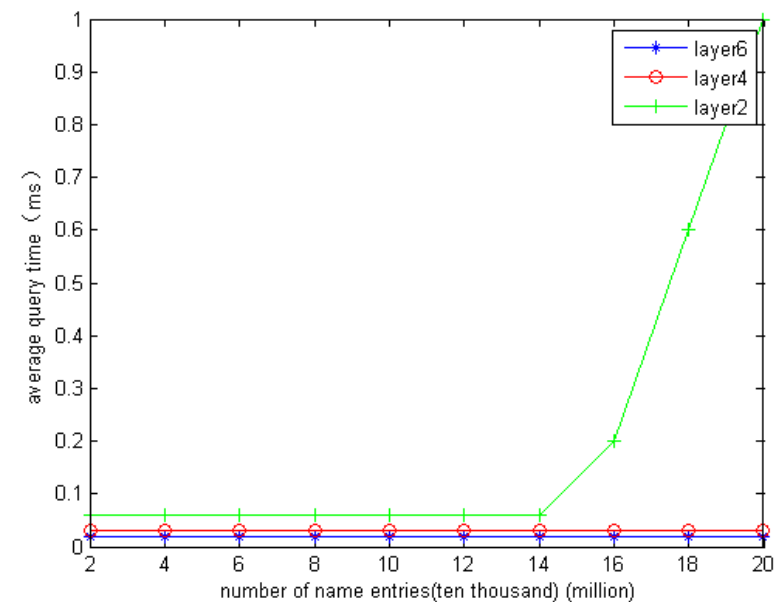
Figure 11. Comparison of query time for large-scale content names.